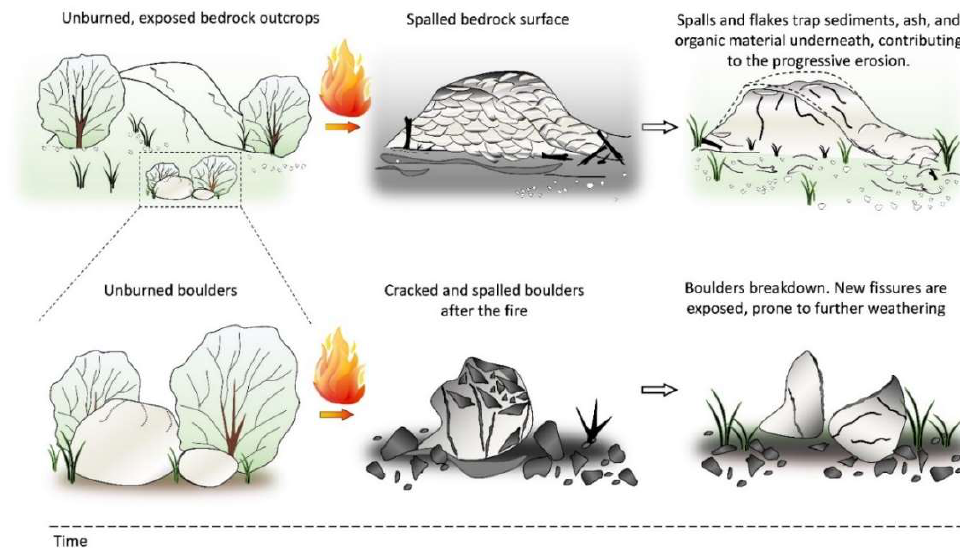
Figure 8. Schematic model of carbonate rock disintegration following forest fires over exposed bedrock outcrops and over detached boulders.